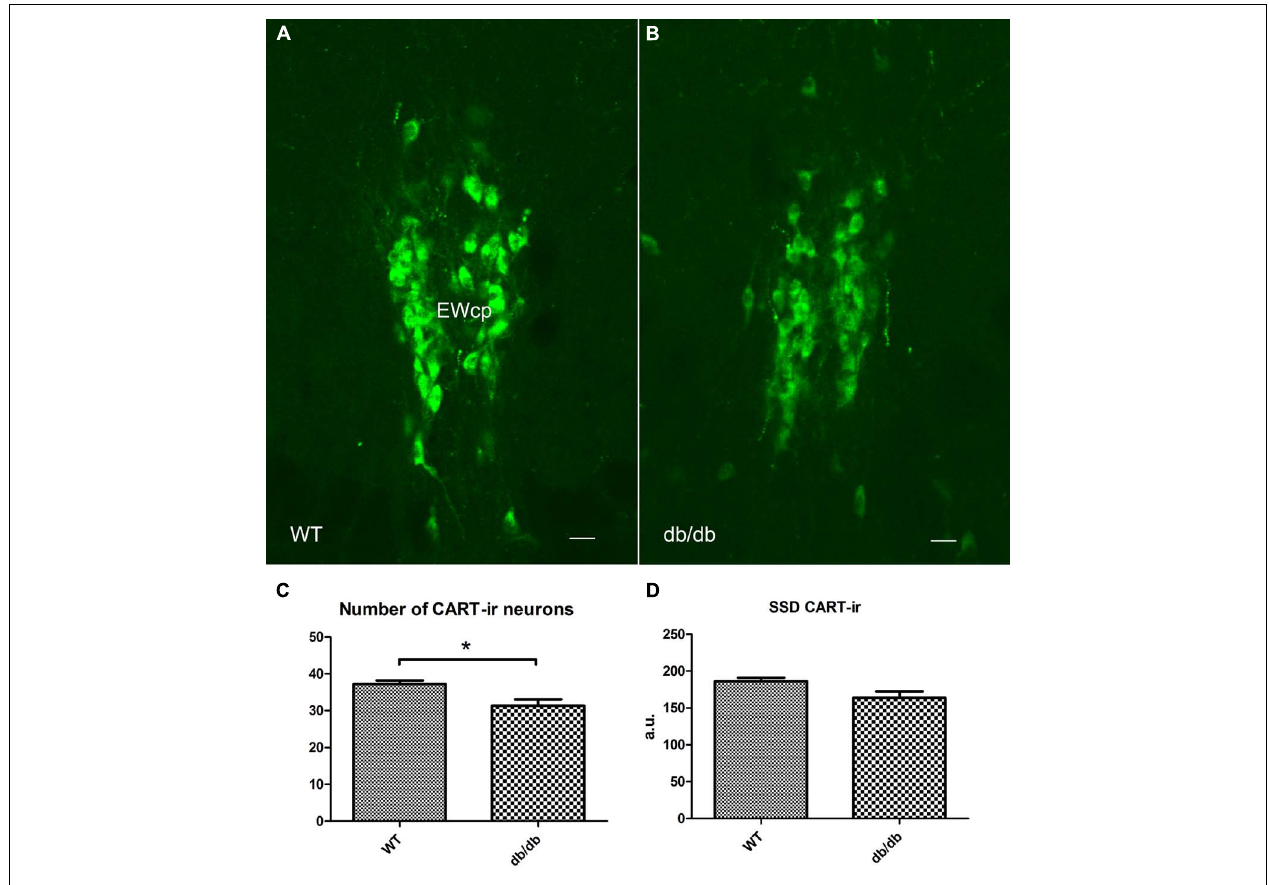
FIGURE 7 | CART content in the EWcp by disrupted leptin signaling. (A,B) , fluorescent immunohistochemistry shows CART-ir in the EWcp inWT and db/db mice. (C,D) , the number and SSD of CART-ir neurons are decreased in db/db mice compared withWT. Scale bars: 20 μ m. * P <